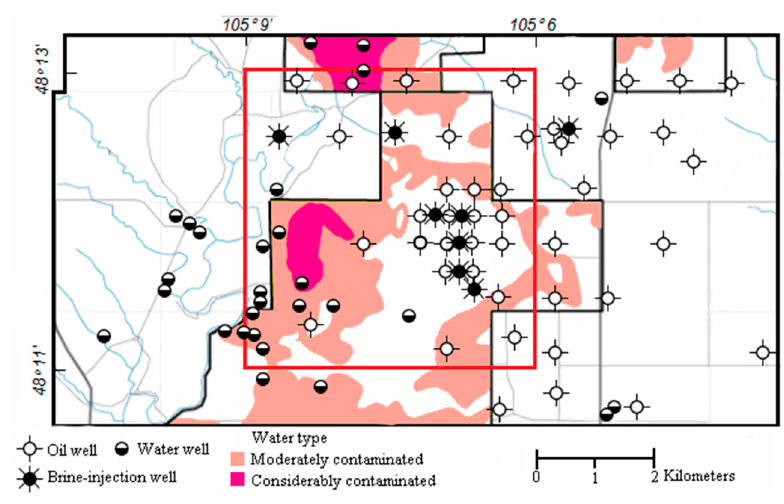
Figure 13. The location of the wells in the research region marked by red rectangle.